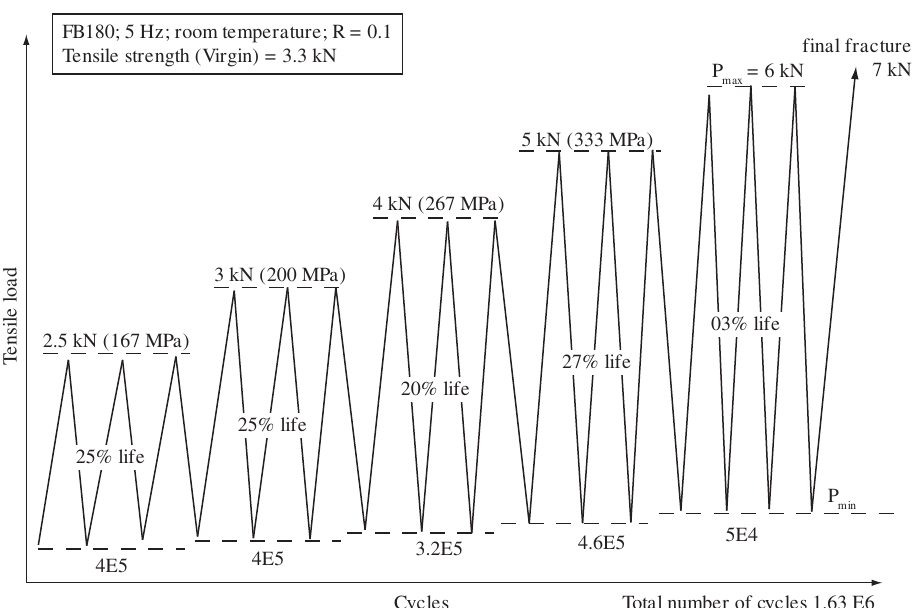
Figure 3. Sequence of cyclic loading blocks applied to the material FB180 (specimen D), leading to its catastrophic failure by fatigue